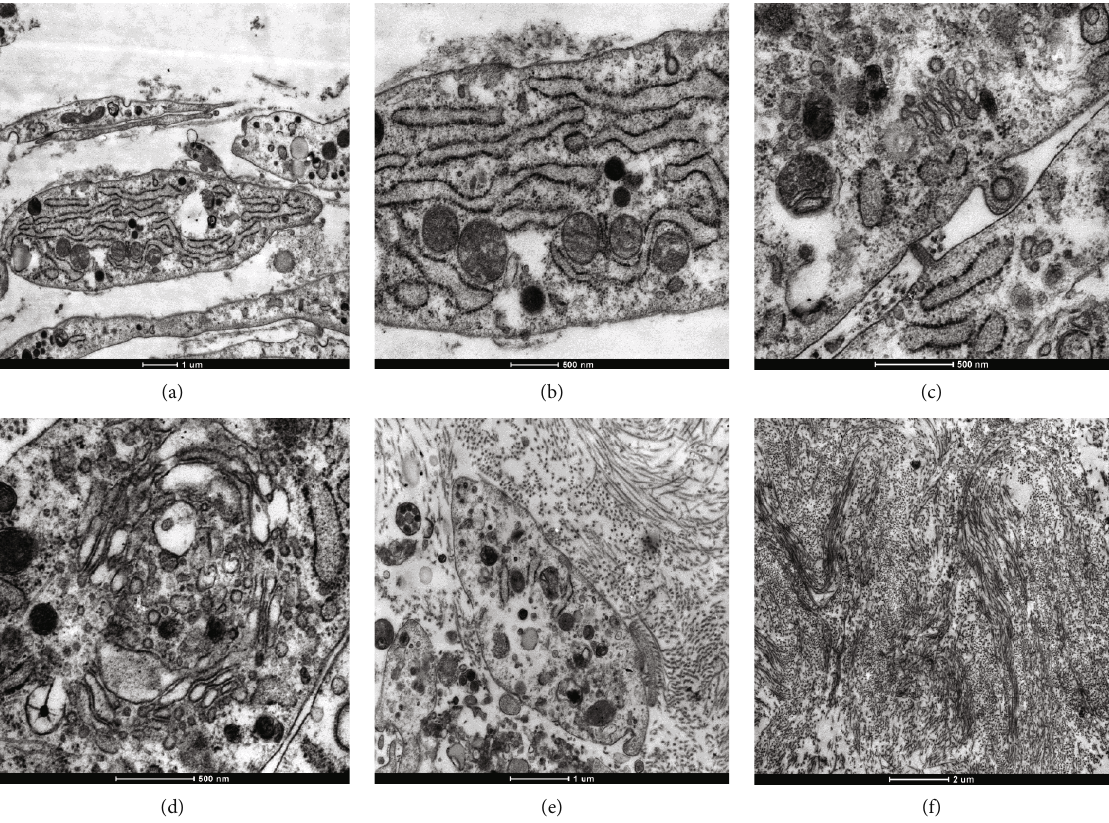
Figure 4: Transmission electron microscope (TEM) observation of ASC sheets on day 7. (a and b) Plenty of rough endoplasmic reticulum and ribosomes were observed in the cytoplasm of cells. (c and d) Abundant Golgi apparatus and exocytosis were observed. (e and f) A large number of collagen fi bers could be seen in the ECM.